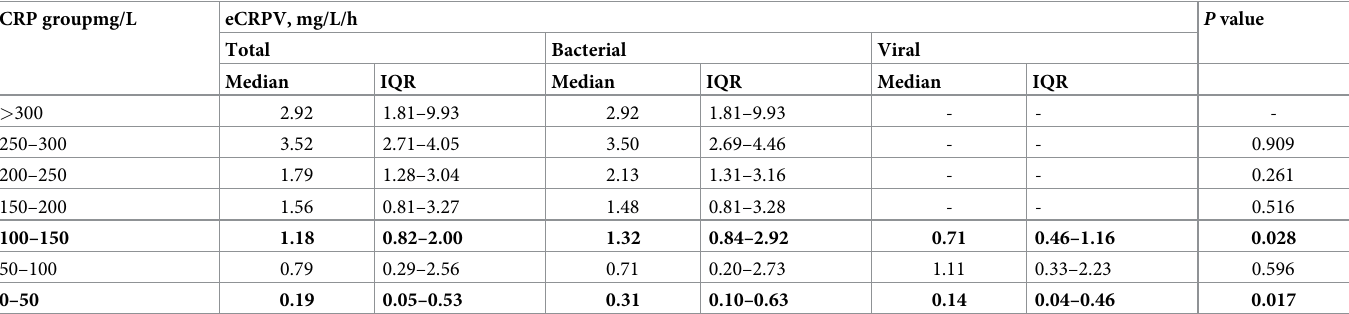
Table 2. eCRPv per CRP levels (iso-CRP).